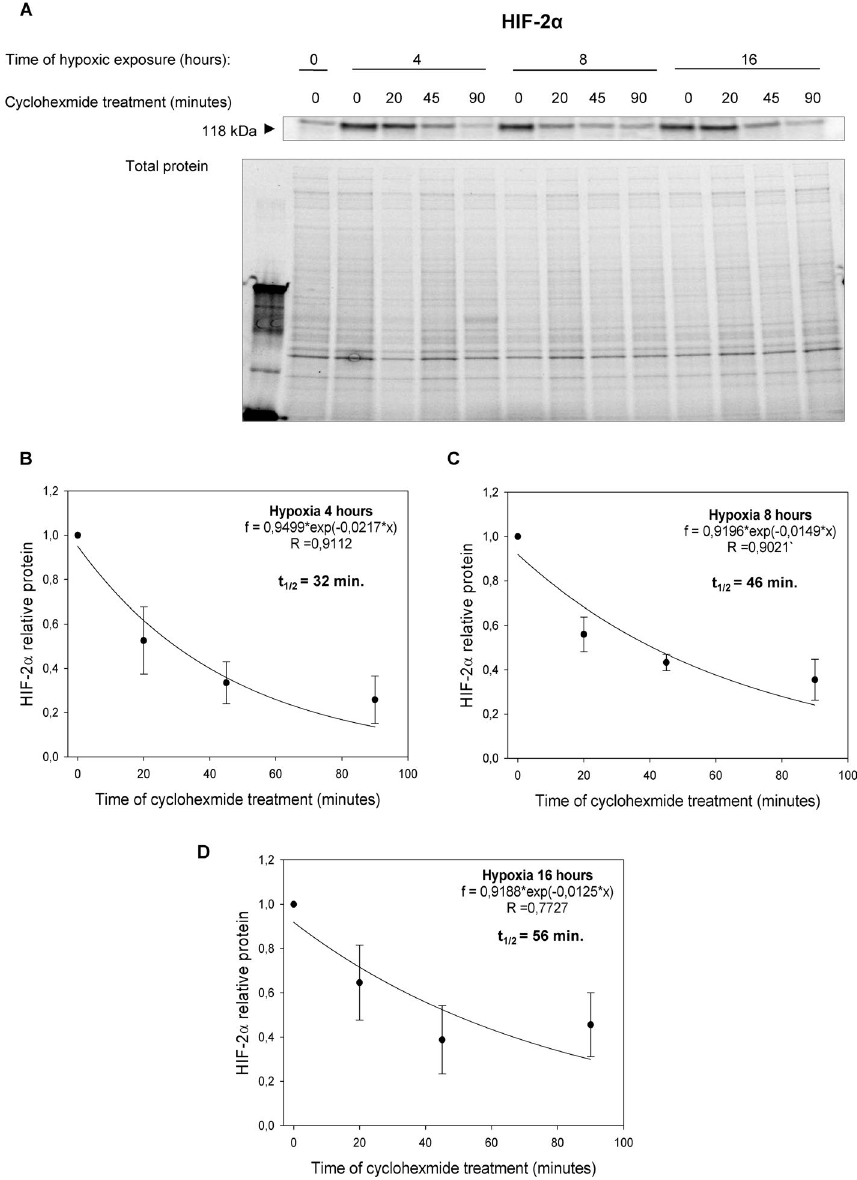
Fig. 3 Hypoxia effect on HIF-2α protein half-live. A HIF-2α half-live measurements were taken in HUVECs exposed to hypoxia for 4, 8, and 16 h (cells cultured in normoxia were negative control). Cycloheximide was added to stop translation, after which protein lysates were collected, and HIF-2α levels at each time point were measured by western blot and normalized to total protein levels. Values for each time point were calculated from three individual samples generated in at least three independent experiments. The mathematical representation of HIF-2α protein levels for 4 h ( B ), 8 h ( C ) and 16 ( D ) hypoxia in HUVECs. The time points indicating relative HIF-1α levels were plotted as differences from HIF-2α levels at the initial time point (t 0). The protein half-lives were calculated from the exponential decay using the trend line equation = C/C 0 e –kdt (where C and C 0 are protein amounts at time t and at the t 0 , respectively, and k d is the protein = decay constant). The error bars represent SD. * P < 0.05 was considered